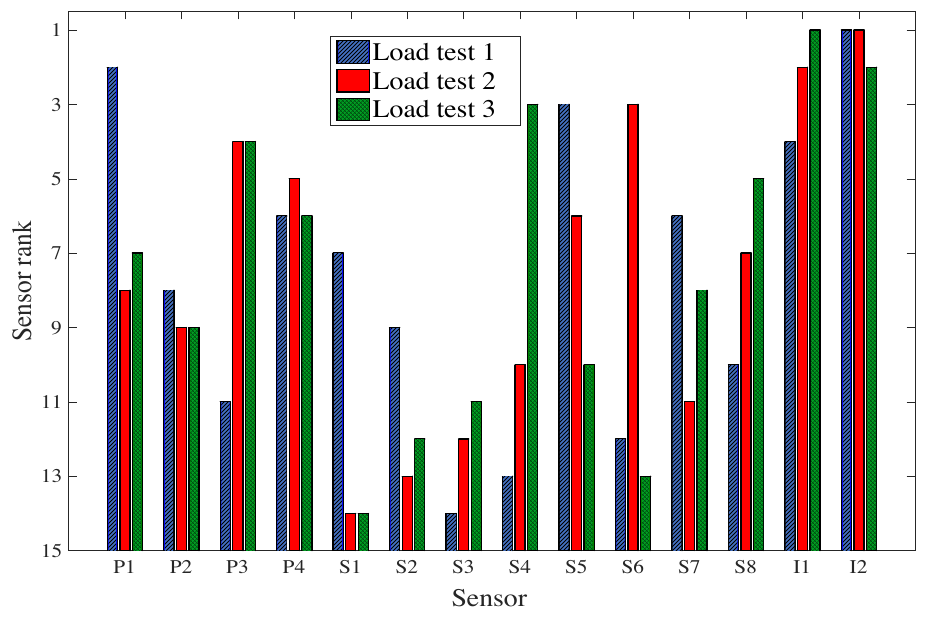
Figure 9. Sensor ranking for three load